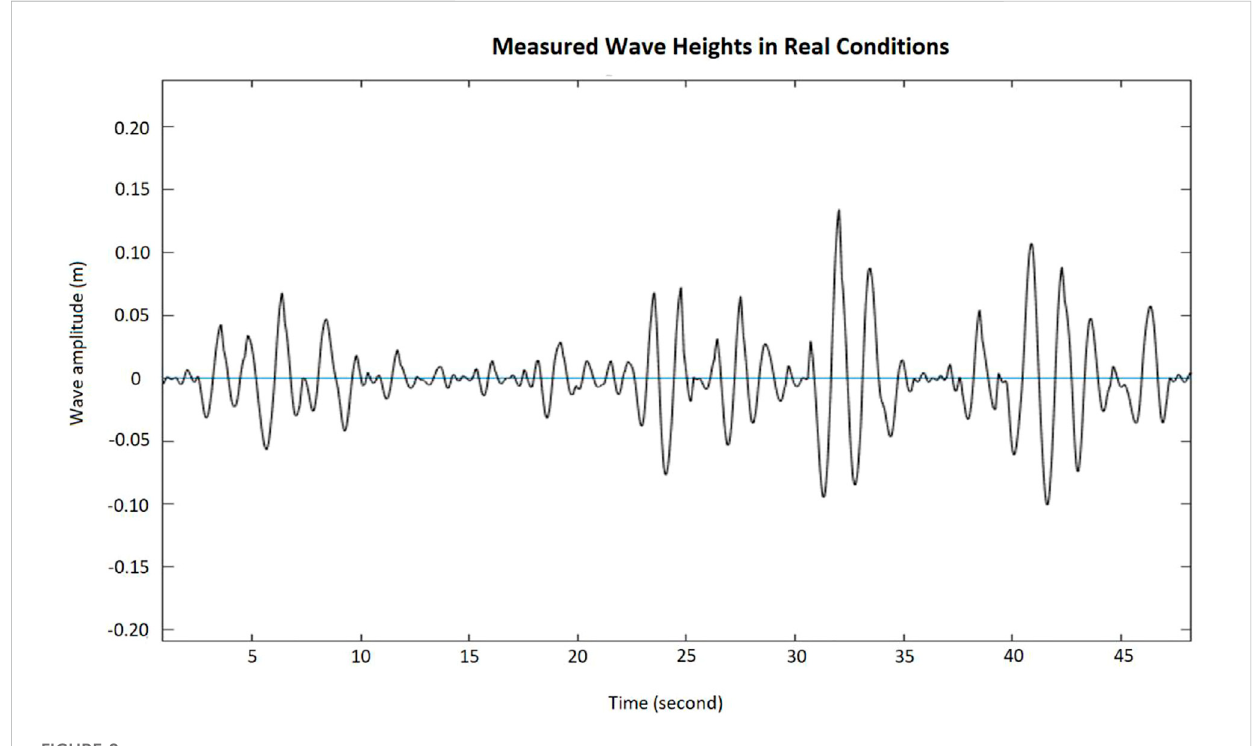
FIGURE 8 Measured wave heights in real conditions.